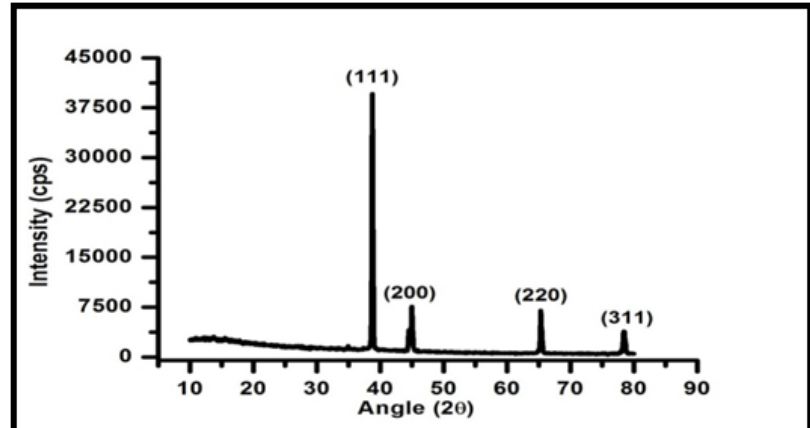
Figure 8. XRD pattern of cast samples with sprue diameter 8 mm